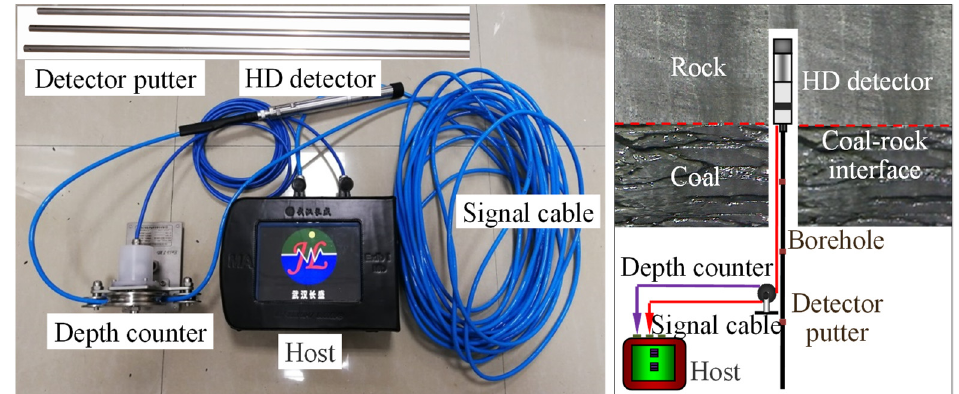
Figure 2. Mining intrinsic safety borehole camera.